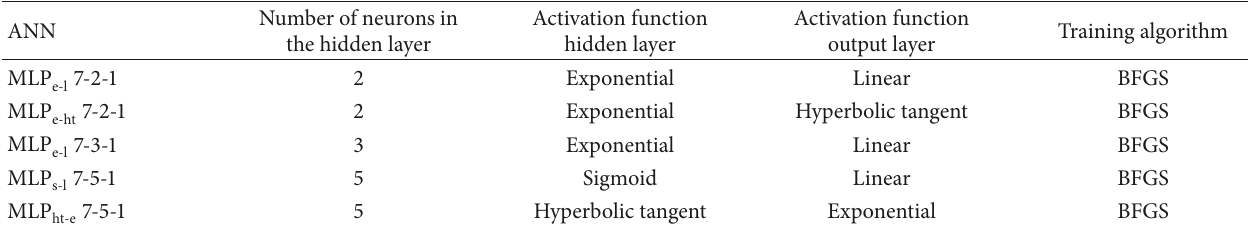
Table 7: Details of the selected ANNs for further training (source: own